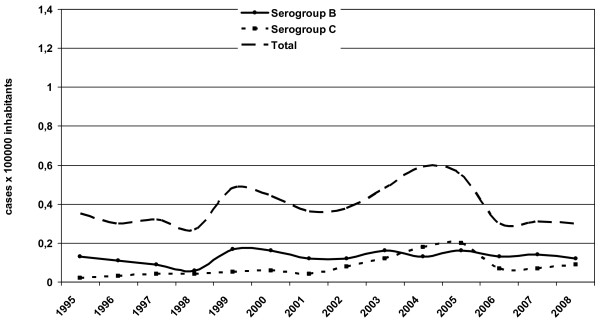
Annual incidence of serogroup B and C invasive meningococcal disease in Italy, 1995–2008 (cases per 100,000 inhabitants).